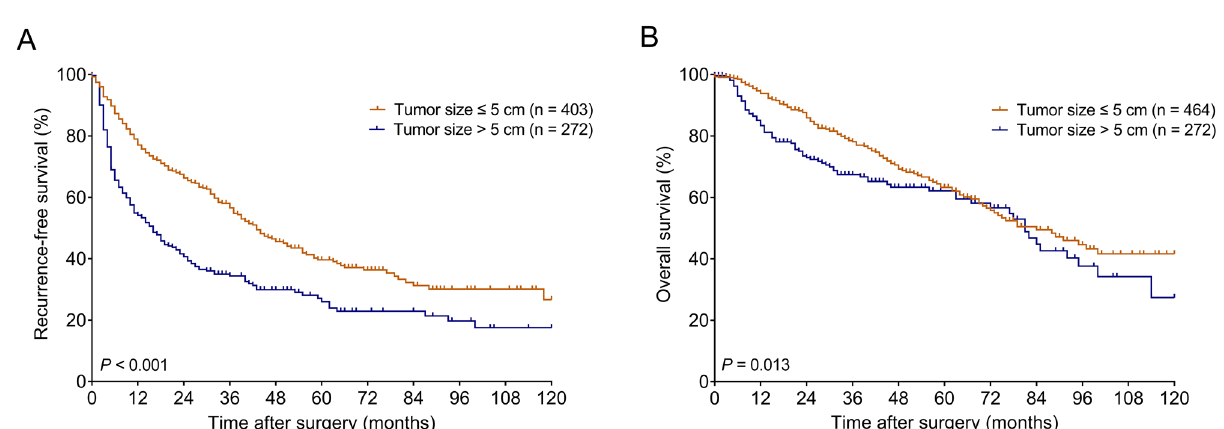
Figure 2. Kaplan–Meier survival curves in the groups stratified by tumor size in patients without microvascular invasion. ( A ) RFS curves. ( B ) OS curves. RFS recurrence-free survival, OS overall